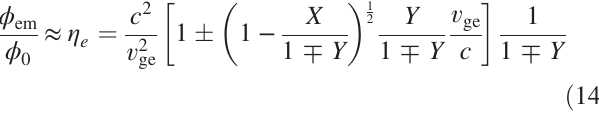
Fig. 1. By propagation of laser pulse through plasma, ponderomotive force of laser pulse F p ∼ ∇ a 2 pushes